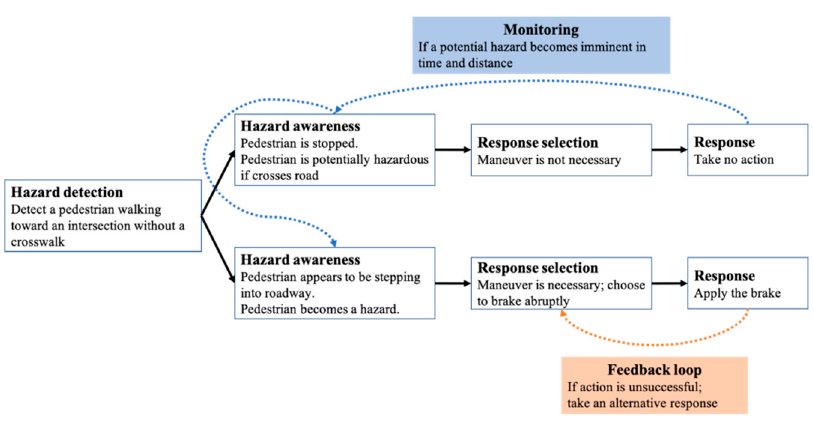
Figure 2. Hazard perception–response framework for the hypothetical case study.